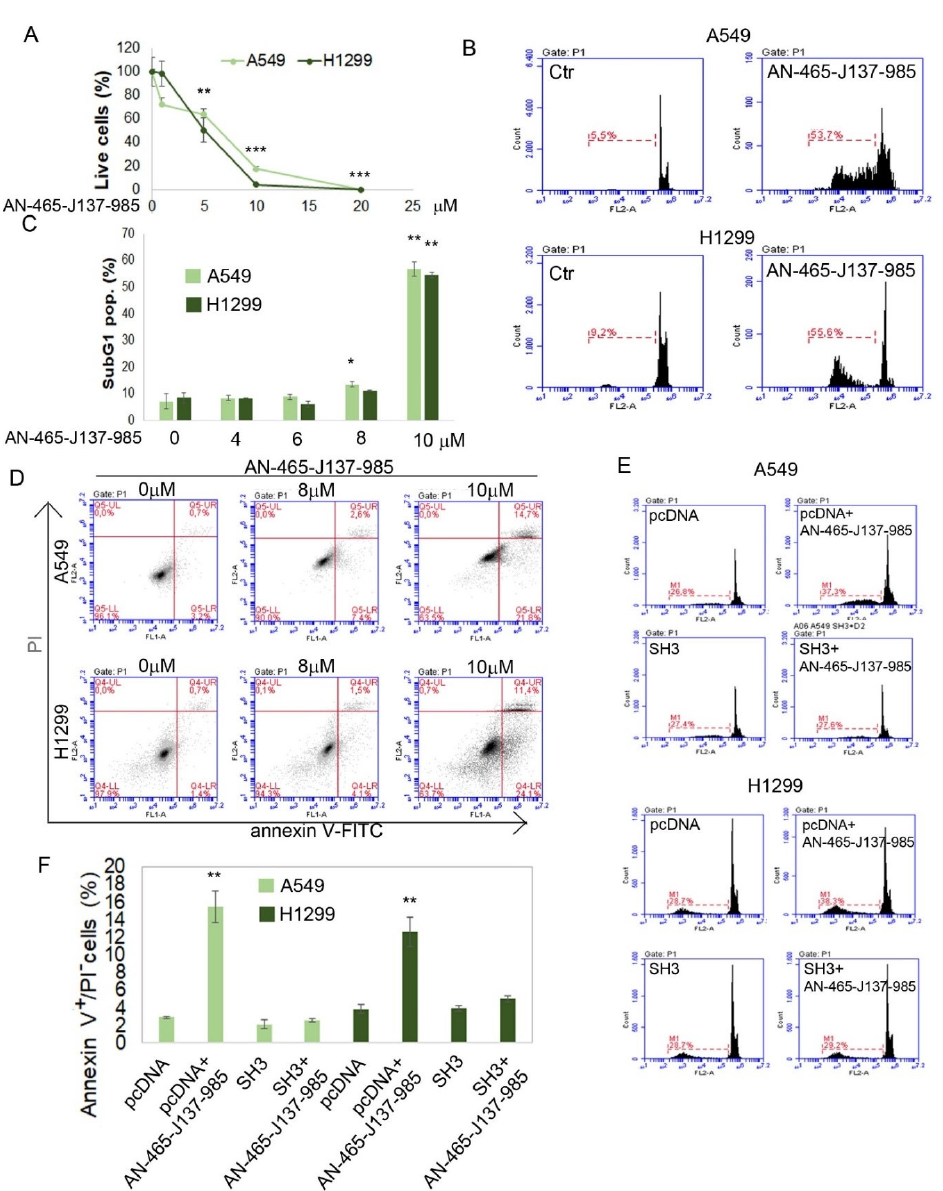
Figure 5. E ff ect of AN-465-J137-985 in A549 and H1299 lung cancer cells. ( A ) Evaluation of cell numbers after 48 h treatment with increasing concentrations of AN-465-J137-985 by trypan blue exclusion assay. ( B – C ) PI staining of cells after 48 h incubation with increasing concentrations of AN-465-J137-985. ( B ) Representative experiments of A549 and H1299 treated or not with 10 µ M AN-465-J137-985. The percentage of sub-G1 population is reported in red. ( C ) Average +/ − standard deviation of the percentage of the Sub-G1 population. ( D ) Annexin-V / PI staining of cells 24 h after treatment with 8 and 10 µ M AN-465-J137-985. ( E ) PI staining of cells 72 h after transfection with the plasmid encoding for C-SH3 of GRb2 or a control plasmid (PCDNA) incubated for 48 h in presence or absence of AN-465-J137-985 8 µ M. ( F ) Annexin-V / PI staining percentage of cells 48 h after transfection with the plasmid encoding for C-SH3 of Grb2 or a control plasmid (PCDNA) incubated for 24 h in the presence or absence of AN-465-J137-985 8 µ M. * p < 0.05, ** p < 0.01, *** p < 0.001. Each experiment have been repeated in